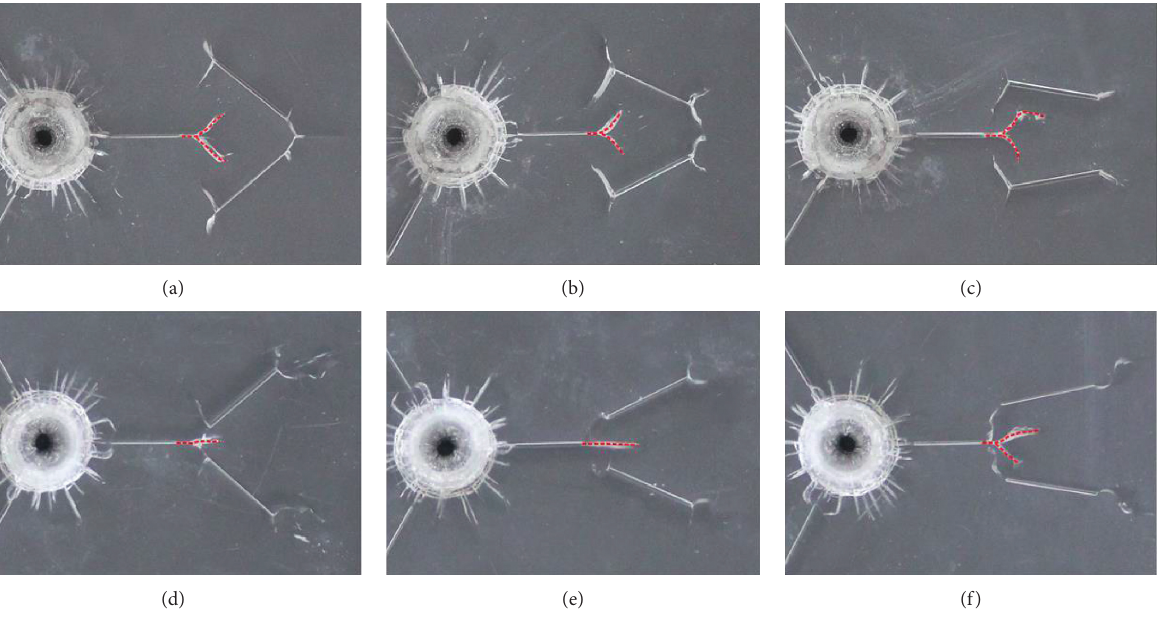
Figure 11: Crack propagation patterns under oblique symmetrical cracks in PMMA specimens. (a) θ � − 80 ° . (b) θ � − 50 ° . (c) θ � − 20 ° . (d) θ � 80 ° . (e) θ � 50 ° . (f) θ � 20 °